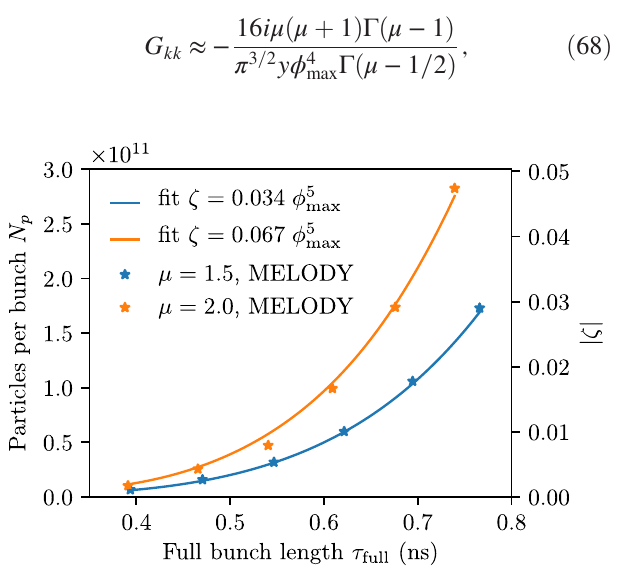
FIG. 18. The LLD intensity threshold as a function of the full bunch length for the inductive impedance Im Z=k ¼ 0 . 07 Ω below transition ( η < 0 ), calculated for the binomial distribution with different values of μ using MELODY (stars) and fitted functions (color lines) for V 0 ¼ 6